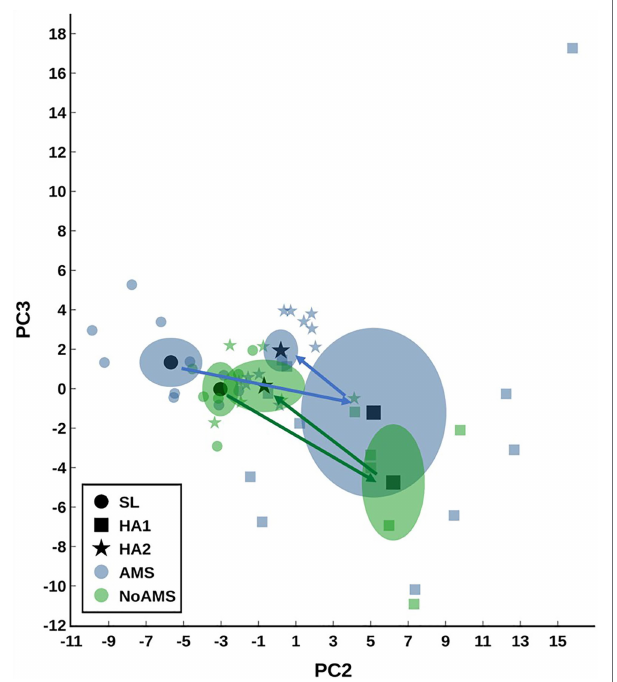
FIGURE 1 | Principal component analysis (PCA) scores plot modeling the urine data for acute mountain sickness (AMS) group at sea level (SL) and high altitude (HA) at Day 1 (HA1). Data for AMS group at high altitude day 18 (HA2) and those for no/mild AMS (NoAMS) group at SL, HA1, and HA2 are superimposed in the model. Data were autoscaled using all groups as reference. Data are plotted showing the centroid mean ± 2 SE (or 95% CI) as well as the individual data points. The arrows show the trajectory from SL to HA1 to